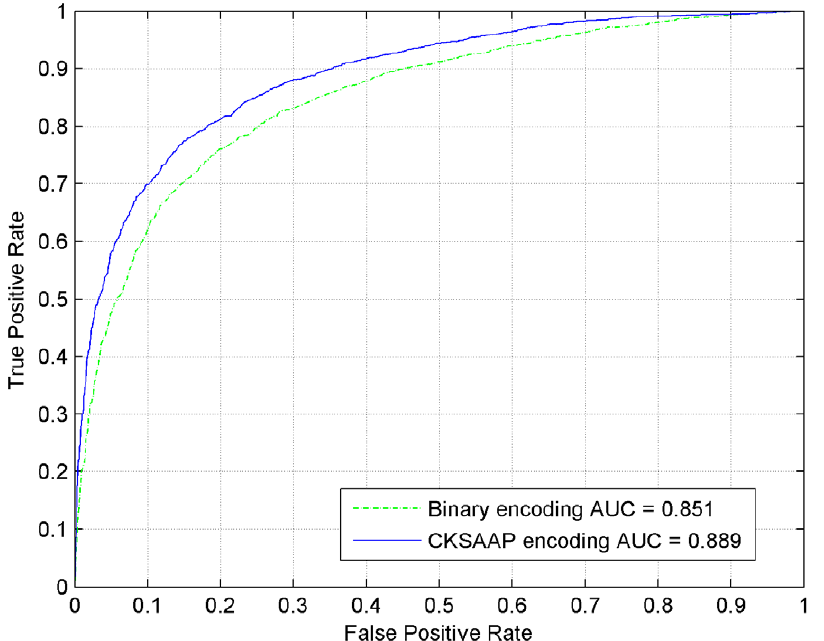
Figure 2. ROC curves of CKSAAP_PhSite and the binary encoding scheme in terms of threonine (T) site prediction based on the training dataset.